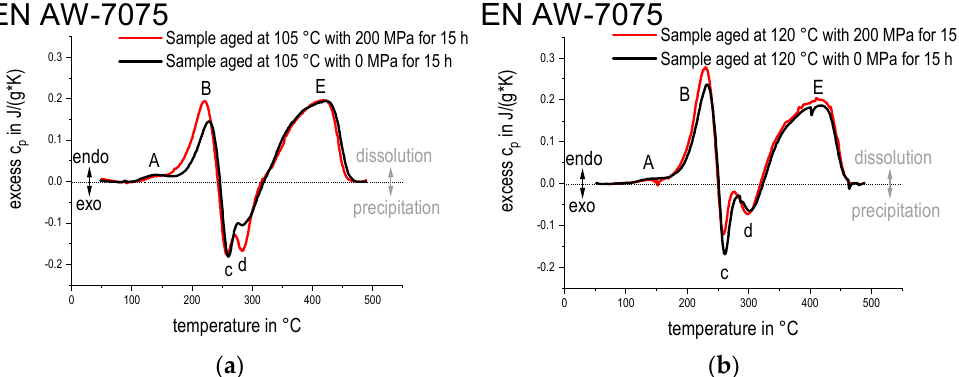
Figure 9. DSC heating experiments conducted using the samples aged at ( a ) 105 °C and ( b ) 120 °C for 15 h with and without superimposed stress of 200 MPa.